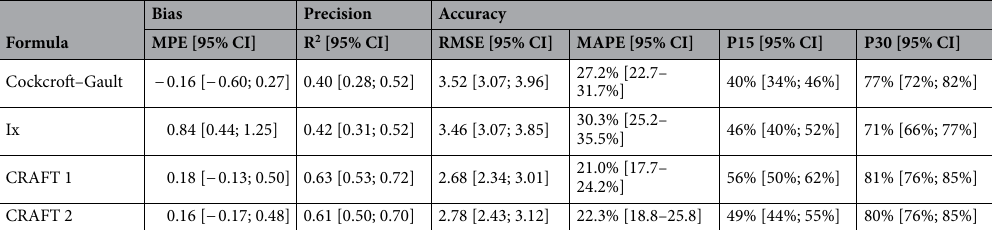
Table 2. Equation performance in validation dataset (n = 266). Confidence intervals were calculated with the combined variance of multiple imputation (10×) and bootstrap (1000×). MPE mean prediction error (mmol/